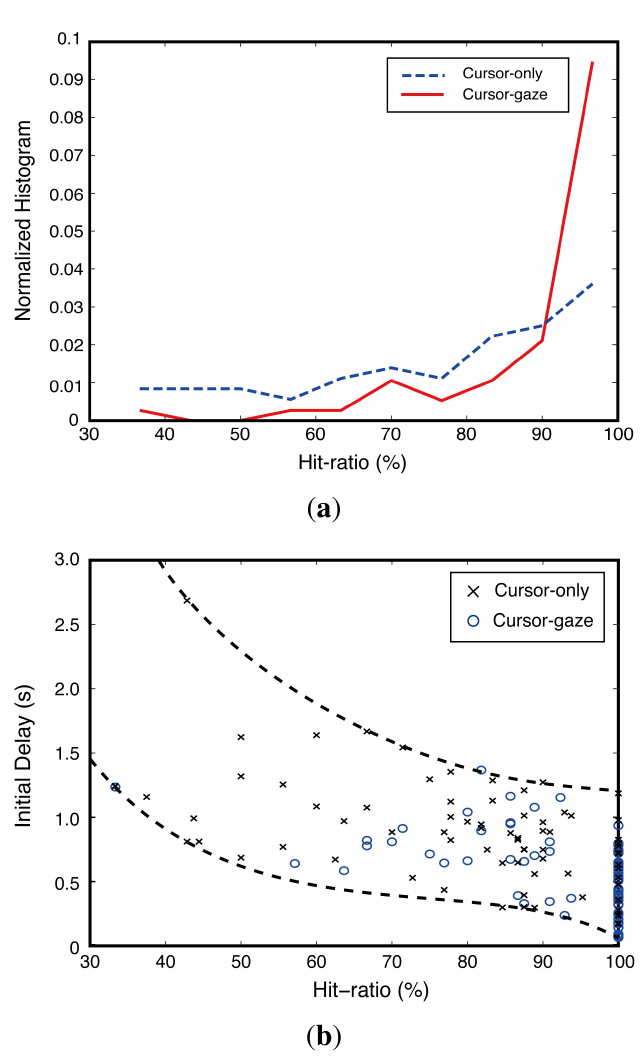
Figure 8. Relationship between hit-ratio and initial delay. ( a ) Normalized histogram of the hit-ratio; ( b ) influence of the